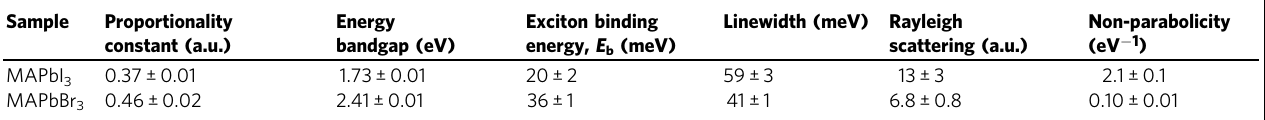
Table 1 Parameters for Elliott Model fi tting of MAPbBr 3 and MAPbI 3 NCs absorption spectra. Sample Proportionality Energy Exciton binding Linewidth (meV) Rayleigh Non-parabolicity constant (a.u.) bandgap (eV) energy, E b (meV) scattering (a.u.) (eV − 1 ) MAPbI 3 0.37 ± 0.01 1.73 ± 0.01 20 ± 2 59 ± 3 13 ±